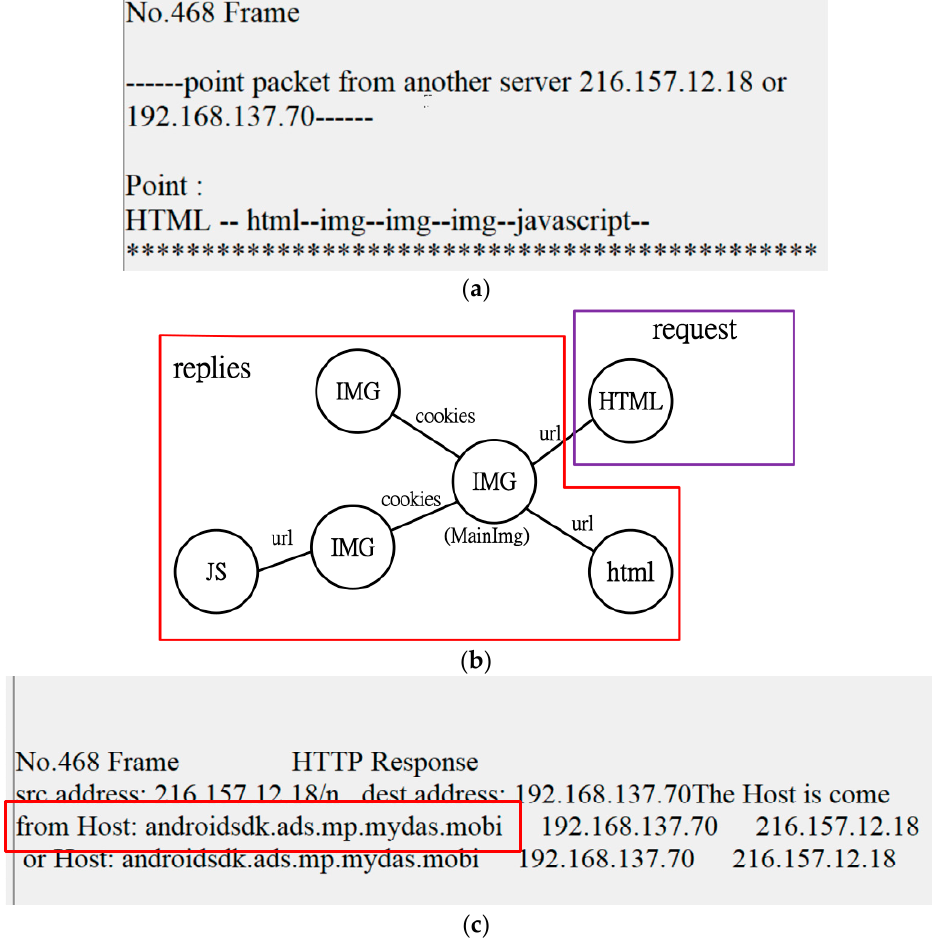
Figure 6. An ad lib discovery, for example ( a ) network patterns ( b ) corresponding graph ( c ) packet details. Table 3. Values of the different types of graphs.